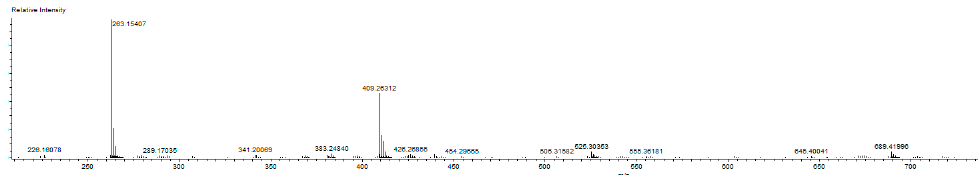
Figure 5. DART MS spectrum (DART-TOF-MS) of complex 3a .